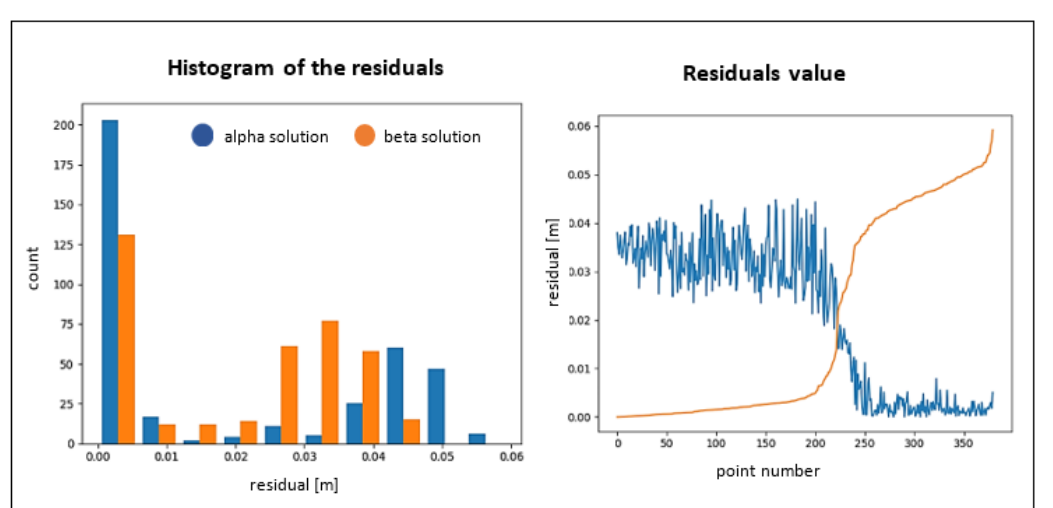
Figure 14. Asphalt road.